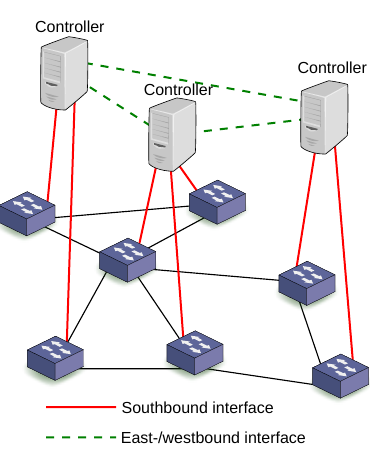
Figure 8. Logically centralized control